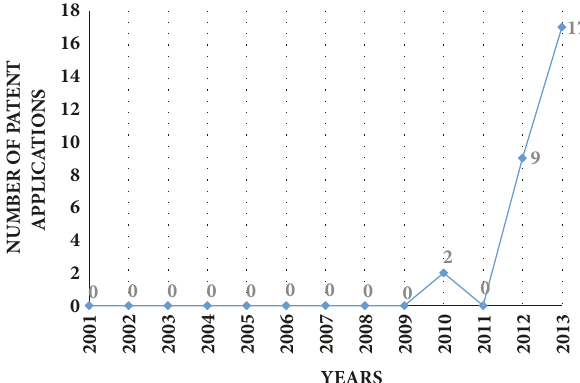
Figure 2: The number of Tencent’s patent applications that Tencent cooperates with heterogeneous institutions in AI technology from 2001 to